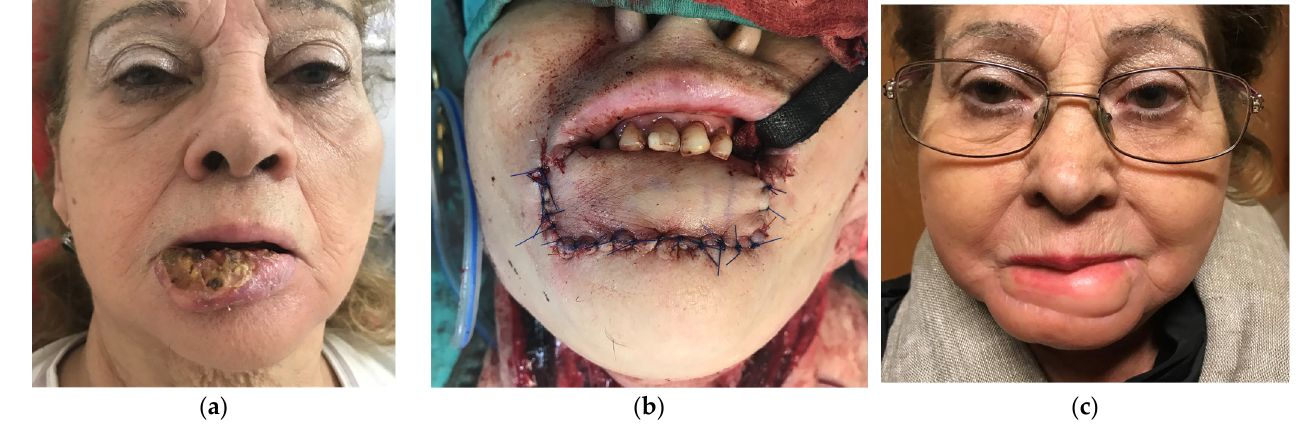
Figure 1. ( a ) Carcinoma of lower lip mucosa involving the skin (stage IV), ( b ) reconstruction of the surgical defect with radial free flap, ( c ) photograph of the patient 4 weeks after